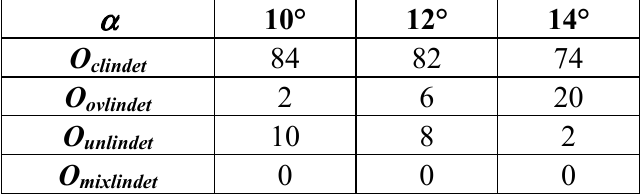
Table 4. Multi-line fractured text segmentation test results.